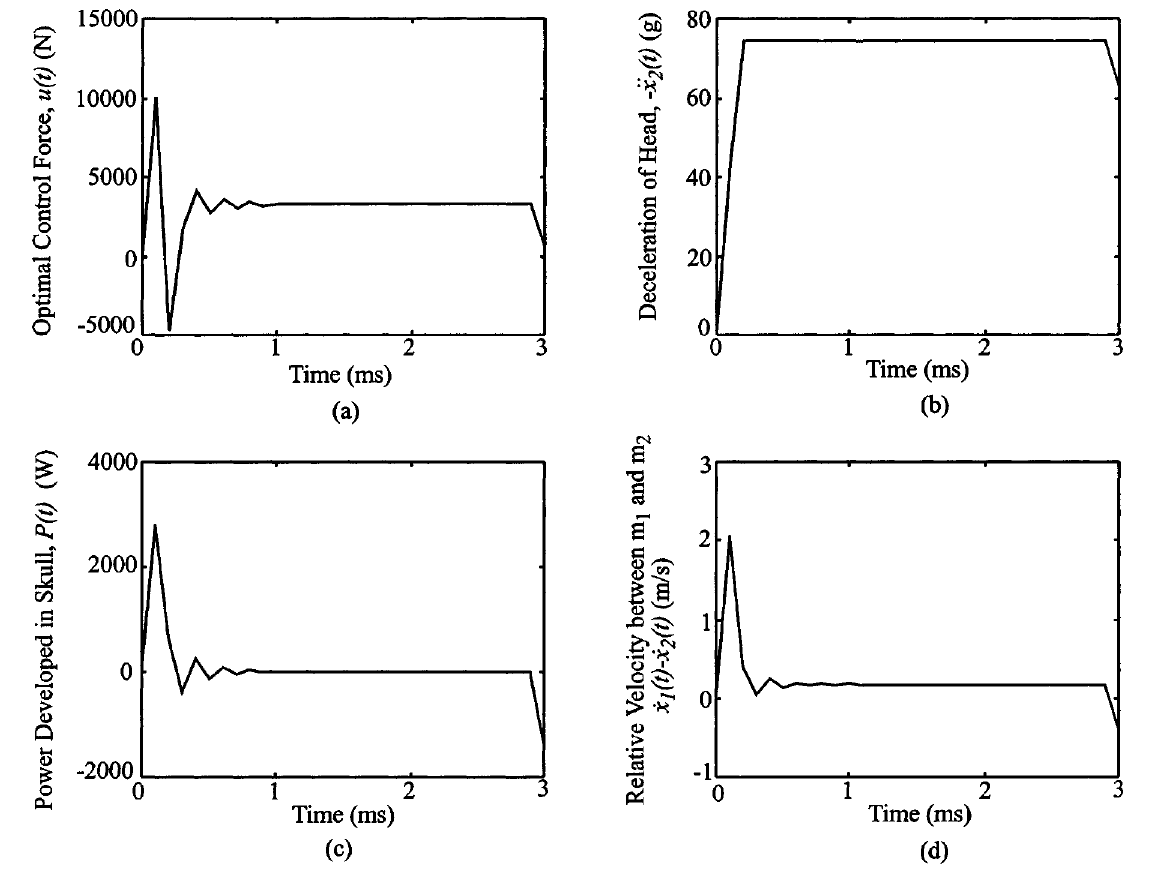
Fig. 14. Time histories of the optimal control force and the system responses. Case 1: Minimization of the peak head acceleration, A–P direction, S